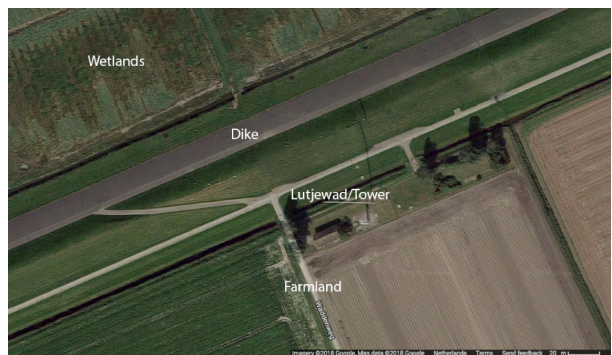
Figure 7. Google Maps image of the atmospheric station Lutjewad and its